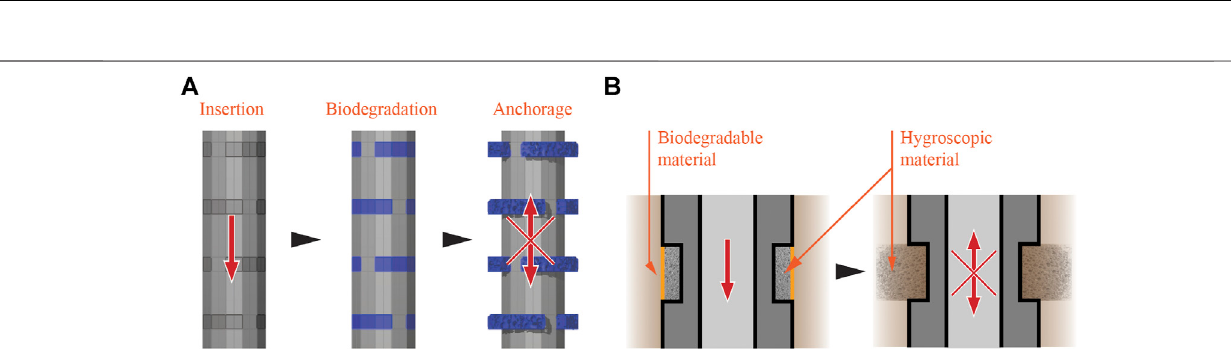
Frontiers in Robotics and AI |